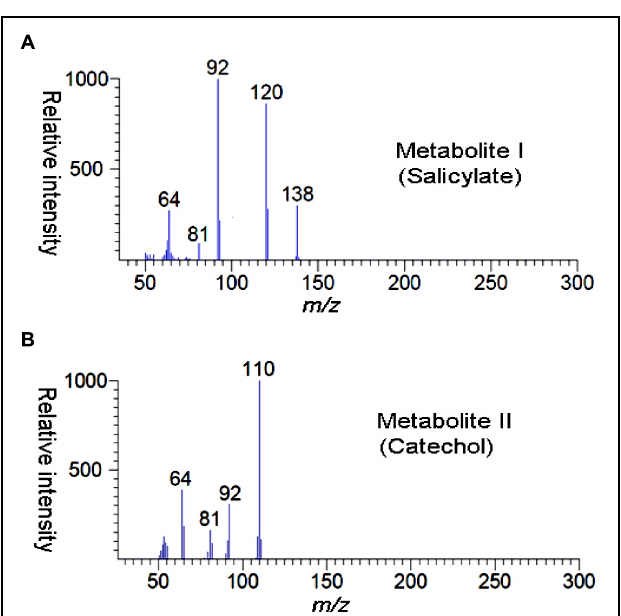
FIGURE 3 | GC–MS spectra of metabolite I (A) and metabolite II (B).